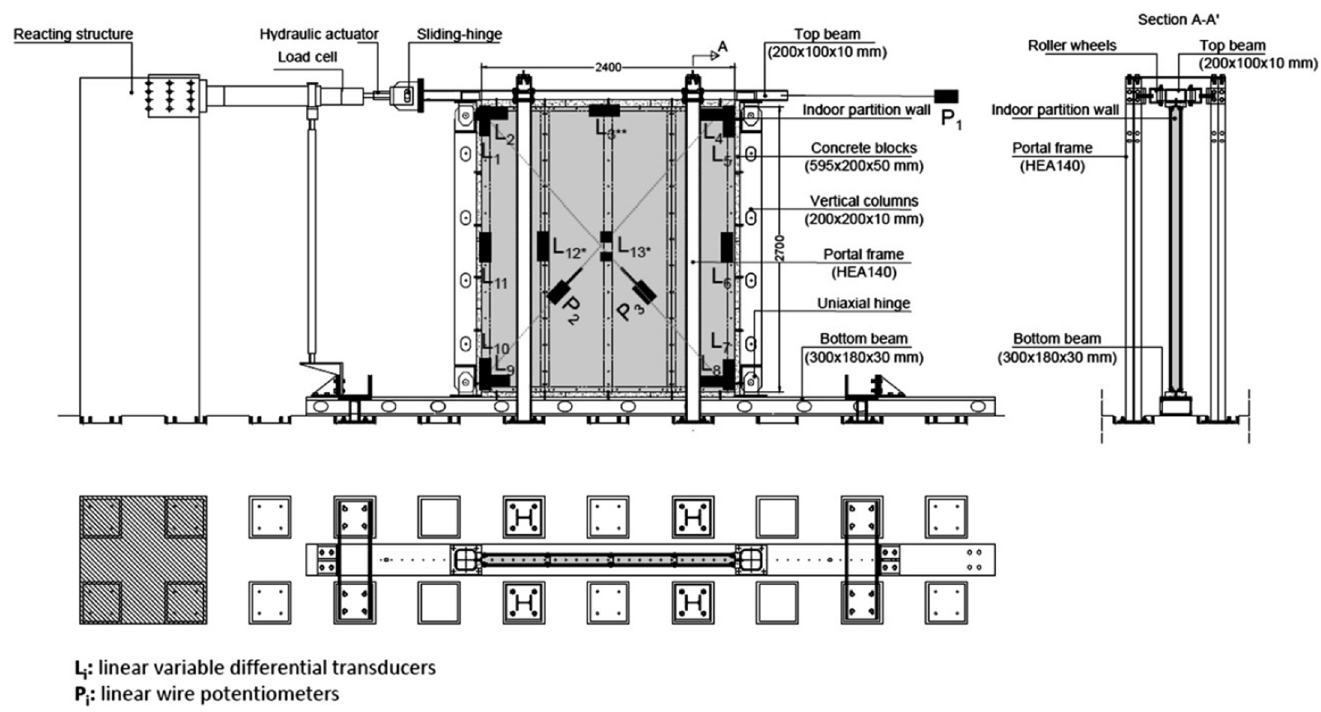
Figure 4. Typical test setup for quasi-static cyclic testing of the drywall partitions [37].